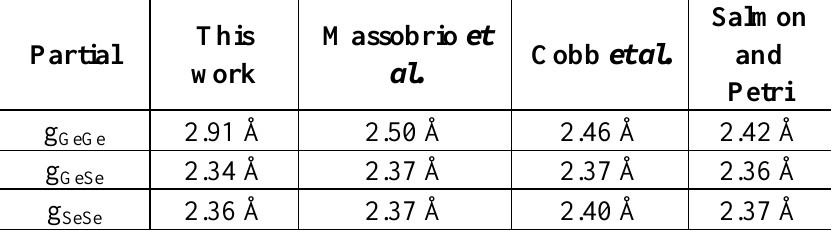
Table 5. Nearest neighbor peaks from the pRDFs obtained in our simulations compared to experiment, Salmon and Petri [95], and to other ab initio work